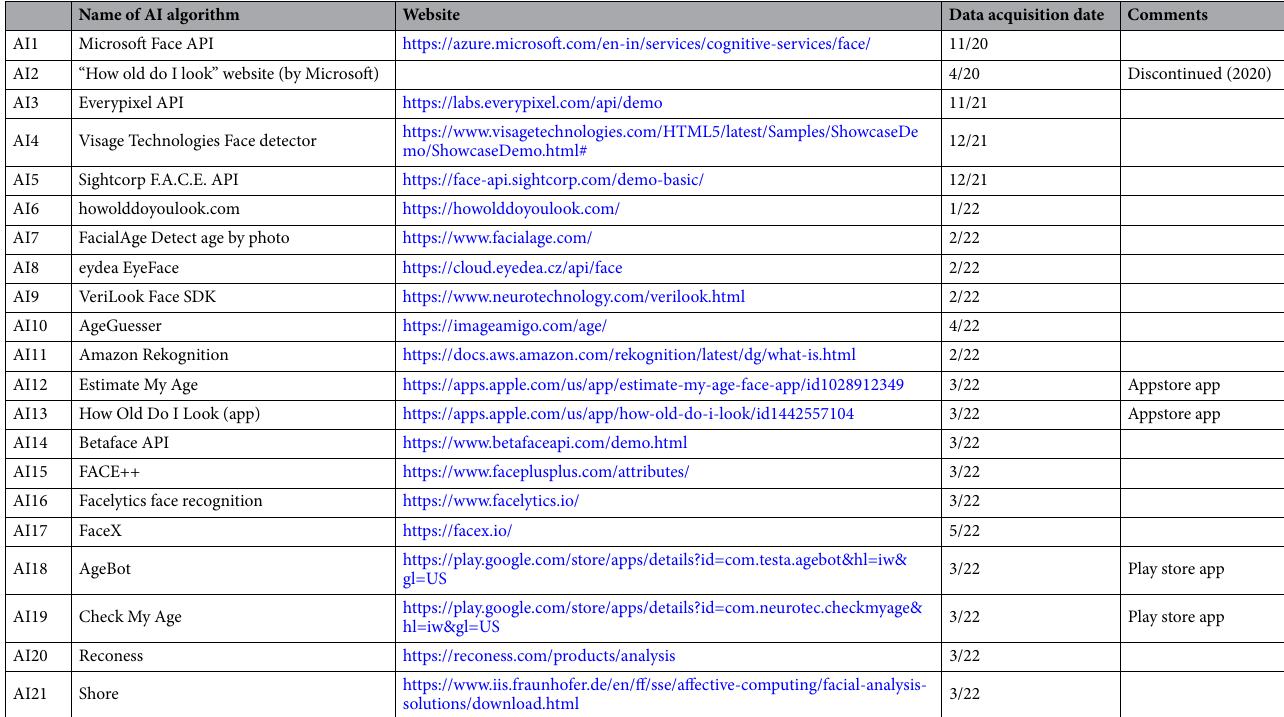
Table 1. Description of the different AIs tested for age